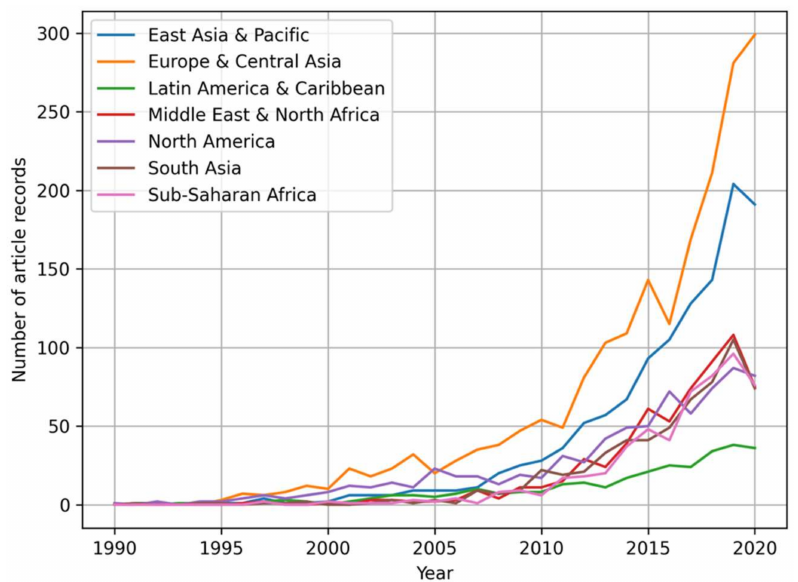
Figure 6. Trends of the article records from 1990–2020 by region classification ( n = 12,368). For each region, the top-three prioritized themes within this review are “r&d”, “human consumption of antimicrobials”, and “human IPC”, respectively (Table 5). The fourth to sixth prioritized themes are “use of antimicrobials in animals” followed by “clean water and sanitation” and “food safety and security”, respectively. The least prioritized themes are “use of antimicrobials in plants” and “environmental contamination” for all regions. Notably, the Middle East and North Africa region prioritizes “food safety and security” over “antimicrobial use in animals” and “clean water and sanitation”. This greater emphasis on food security reflects the Middle East and North Africa region having the world’s largest food deficit, with 25–50% of the region’s food being imported [19]. These results continue to suggest the prioritization of human and animal-focused One Health achievements in the past 30 years on a global scale, overlooking the environment, as well as plants, which are dissemination pathways to humans and